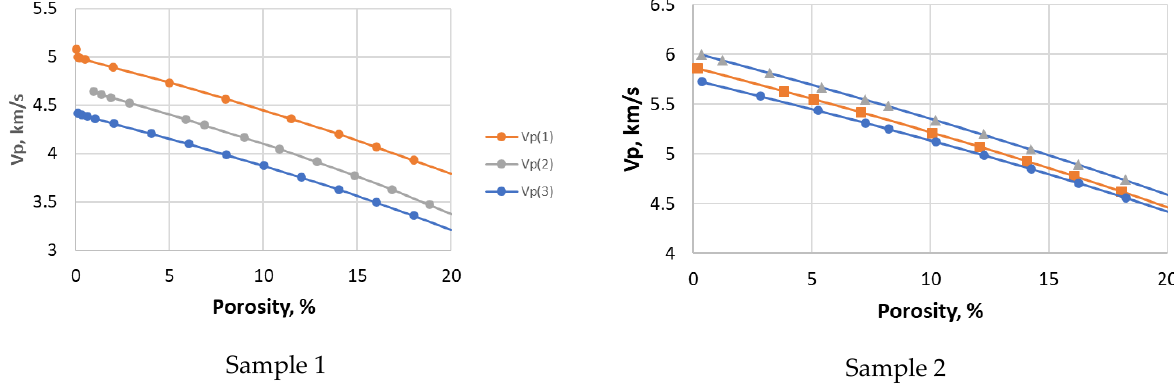
Table 2. Microcrack parameter corresponding to the most probable solutions.